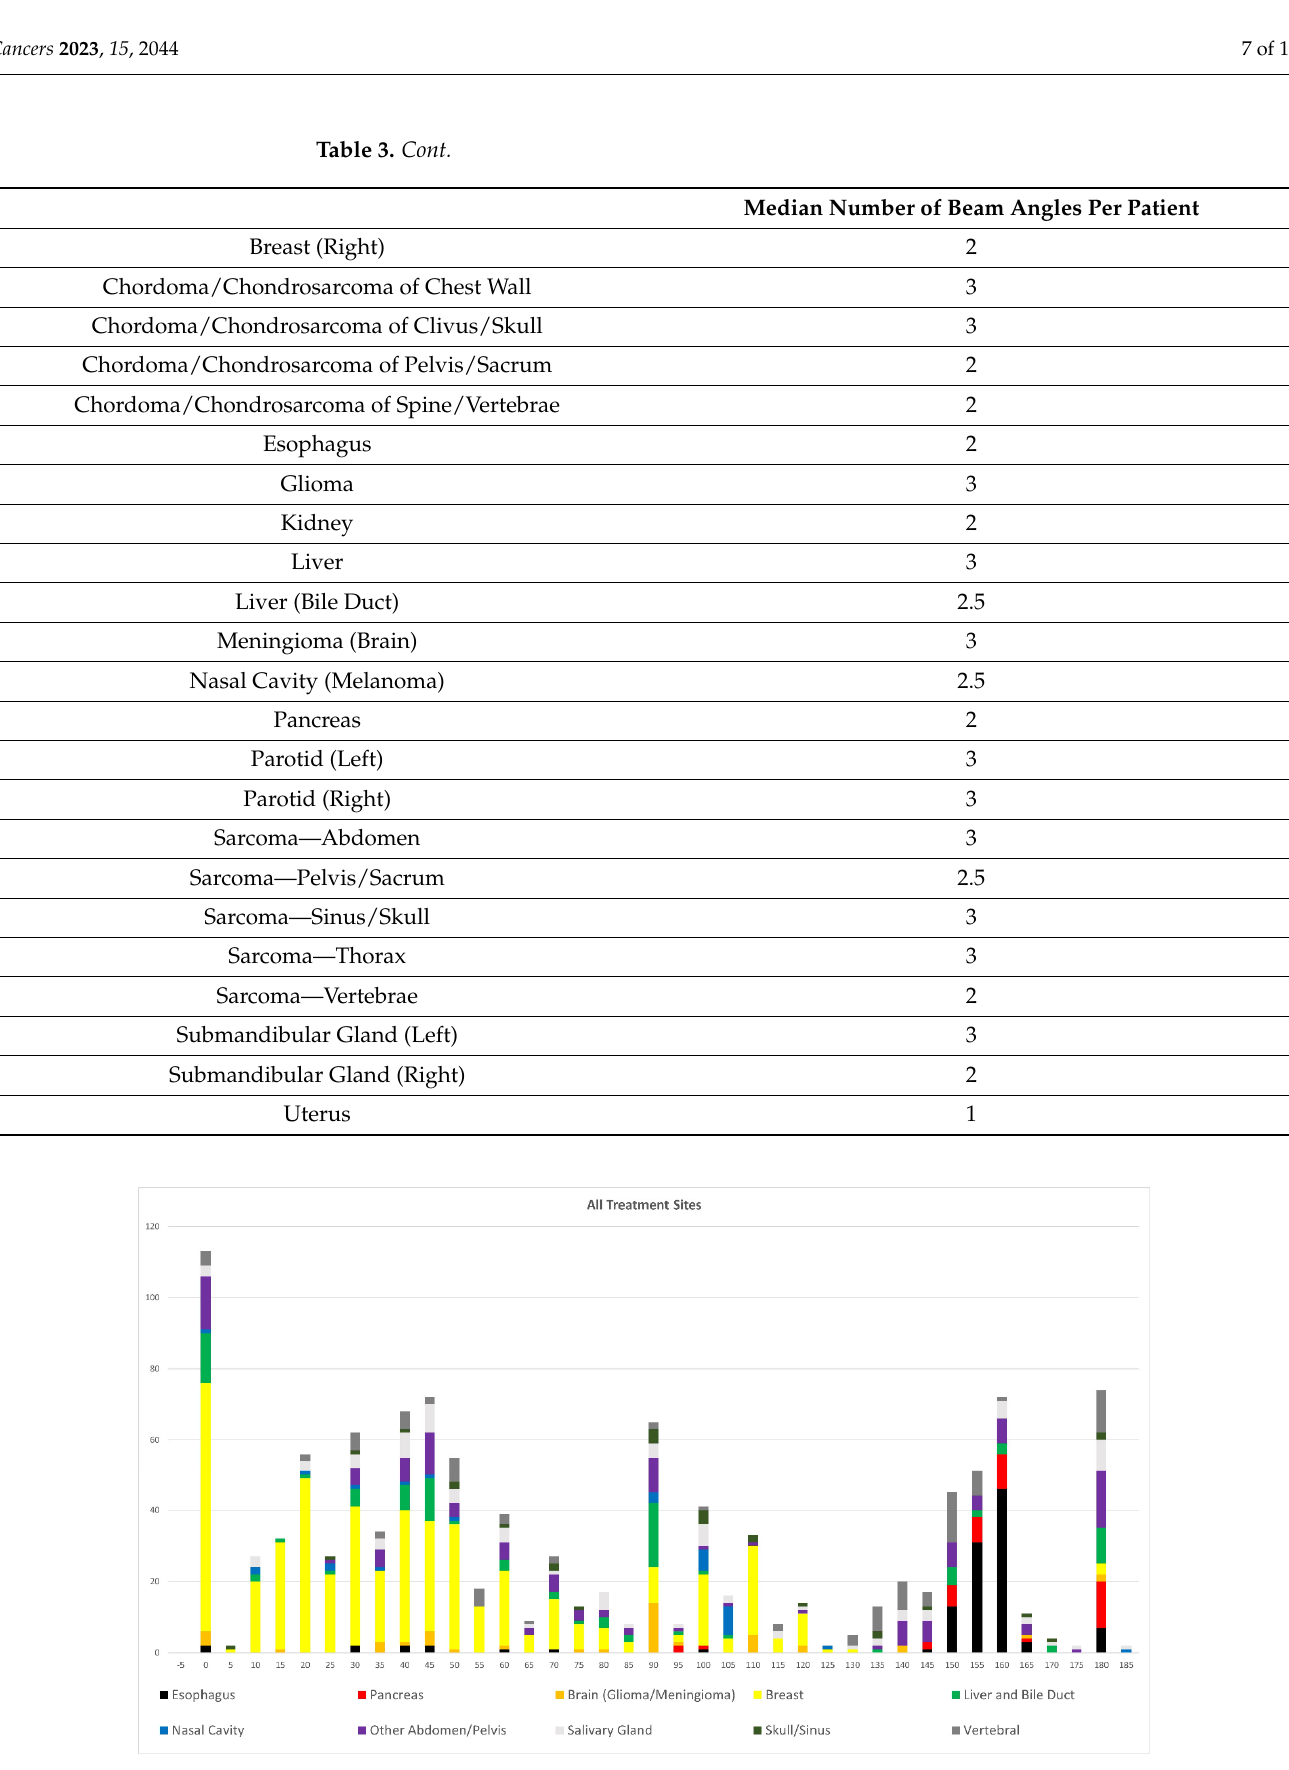
Figure 2. Demonstration of the number of beams ( y ‐ axis) used at each angle ( x ‐ axis) by primary tumor treatment site (color coded).